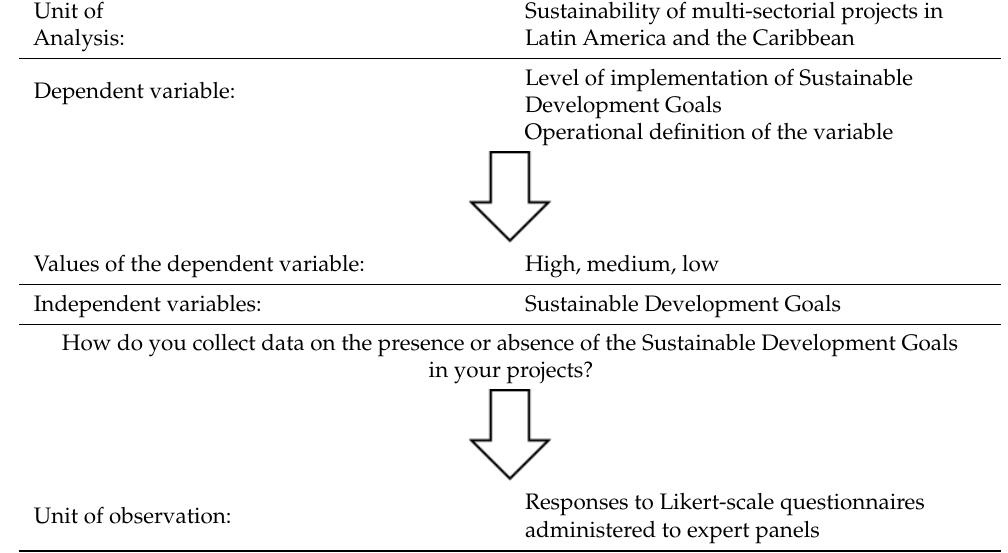
Table 6. Research design.